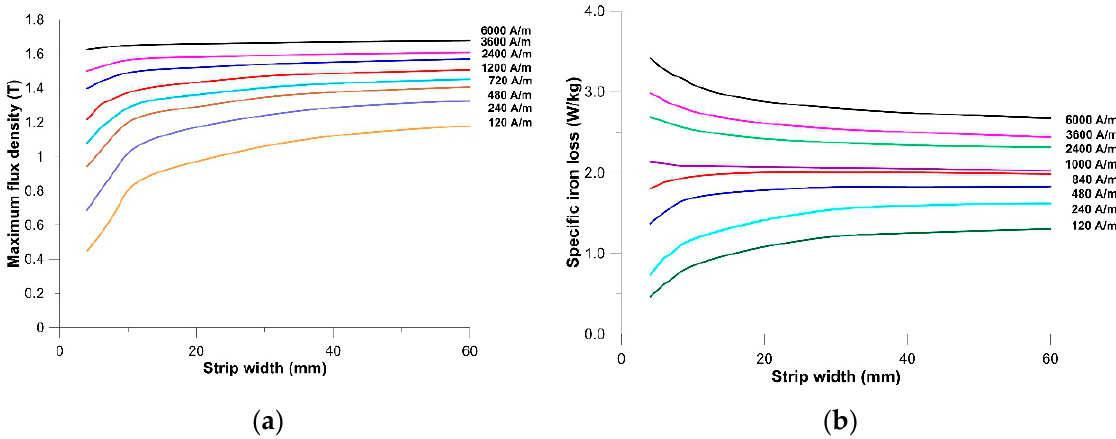
Figure 2. Measured curves for M250-35A material, cut at an angle of 0 degrees. Both curves family are presented for specified magnetic field strength: ( a ) B vs. d ; ( b ) p vs. d at 50 Hz.